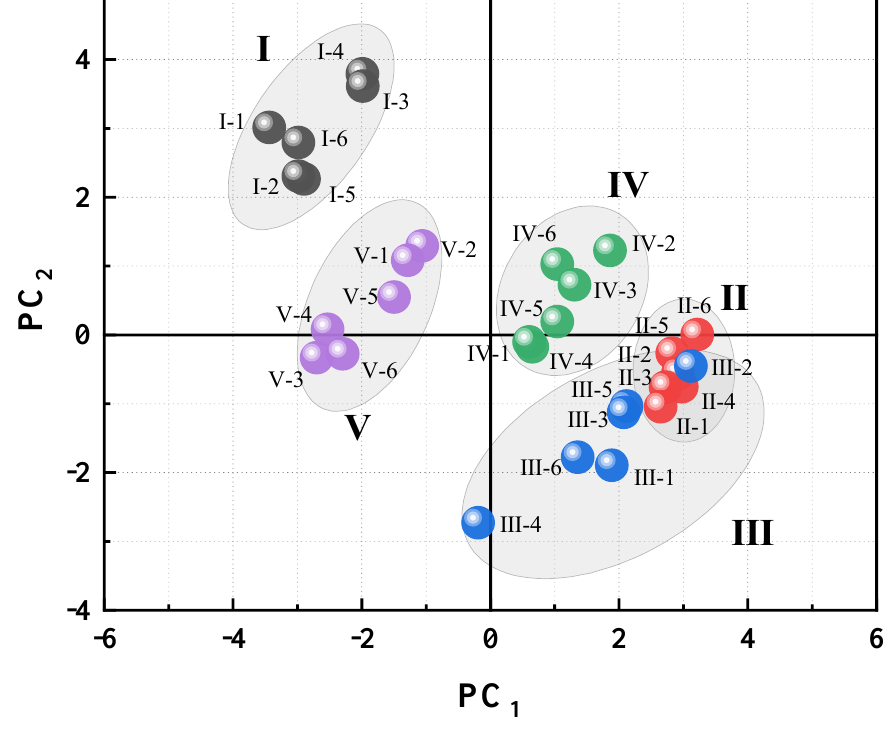
Figure 6. Score chart for PCA of asphalt